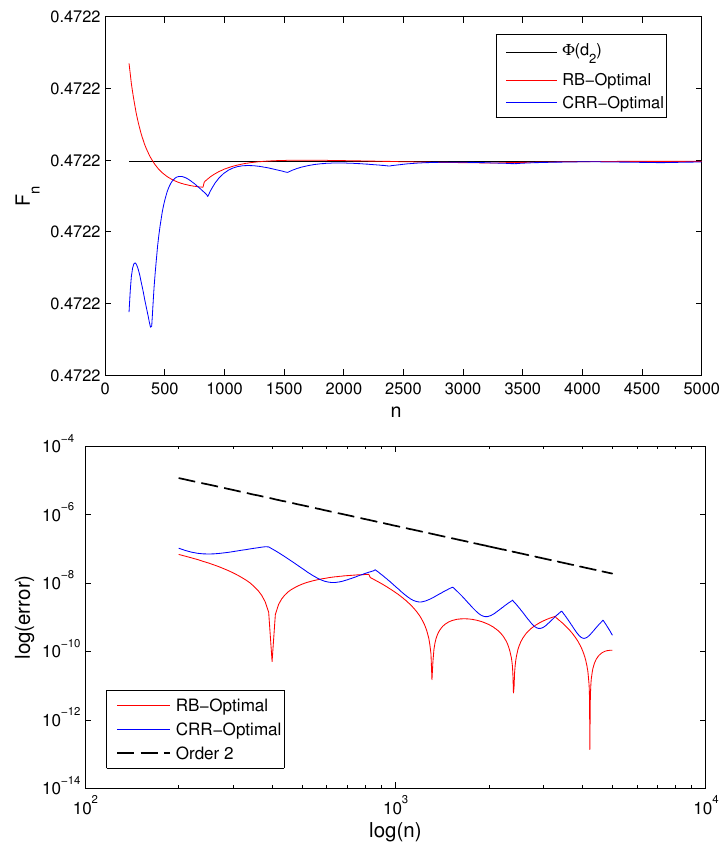
Figure 1. Distributional fit with s 0 = 95, x = 100, r = 0.1, σ = 0.25, T =